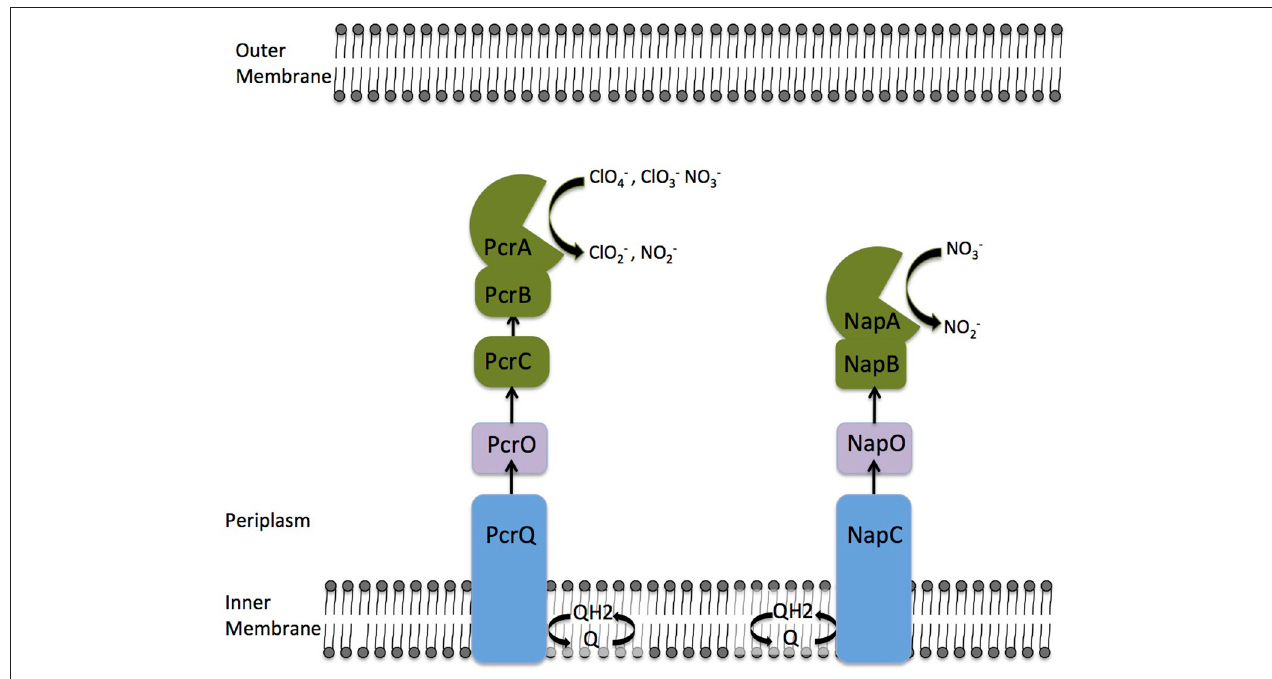
FIGURE 1 | A model displaying proposed electron transfer networks between the quinone pool and PcrABC/NapAB respiratory complexes in Azospira suillum PS. Arrows indicate the canonical electron transfer pathways. The nitrate and perchlorate reductase complexes are painted green. Redundant electron transfer proteins are painted with the same